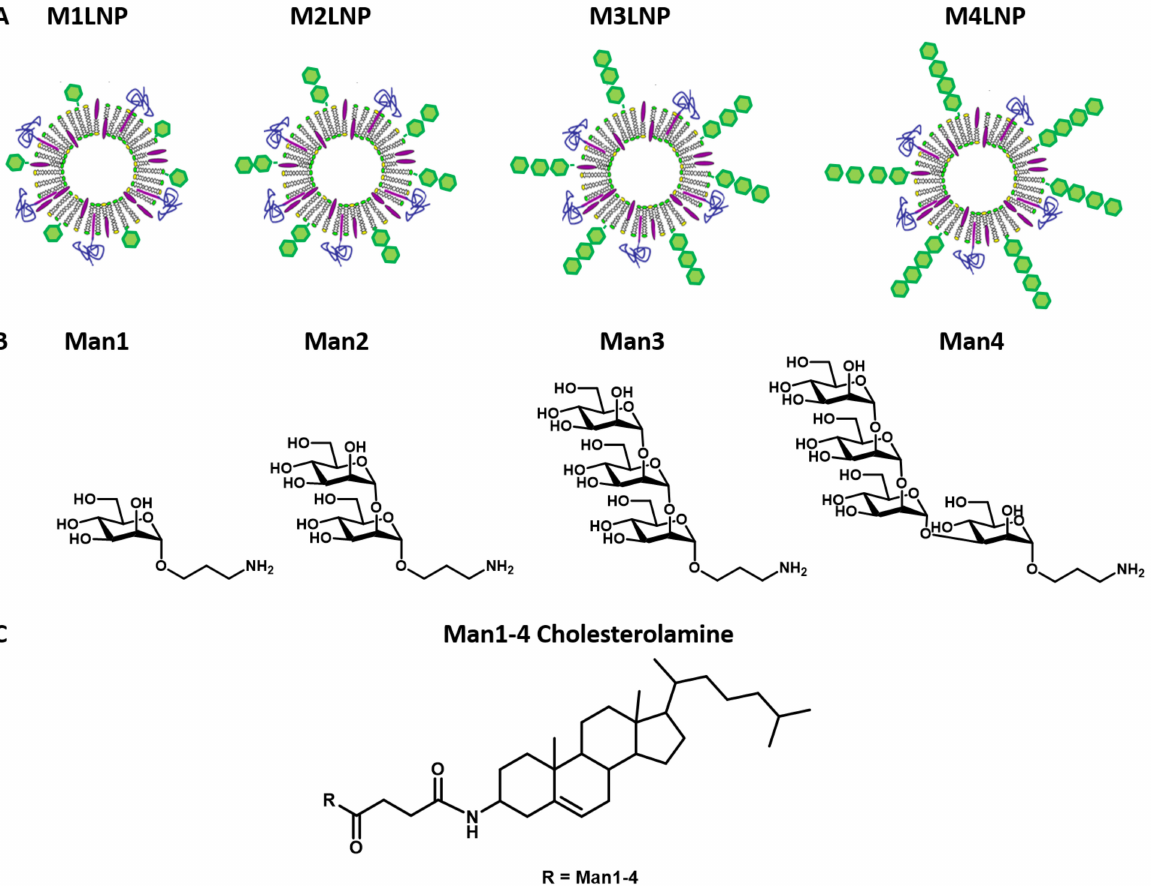
Figure 1. Structure of the synthesized Lipid nanoparticles (LNPs). ( A ) LNPs modified with mono- ( M1 ), di- ( M2 ), tri- ( M3 ), and tetramannoside ( M4 ) combined with PEG chains protruding out of the surface of MLNPs. ( B ) Chemical structure of mannan ligands Man1 ( M1 ), Man2 ( M2 ), Man3 ( M3 ), and Man4 ( M4 ) connected to linker; ( C ) Chemical structure of mannan ligands conjugated to cholesterol-amine. The ligand and PEG chain lengths are not to scale and are not representative of the real surface projection on MLNPs. The higher chain length mannans are expected to be least affected by the ligand masking effect of the PEG